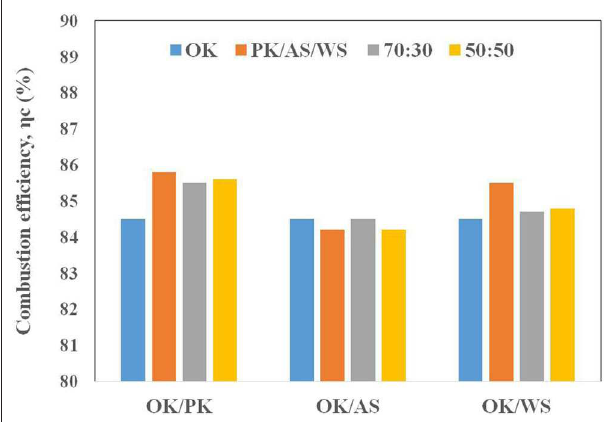
FIGURE 7 | Combustion efficiency of fuel